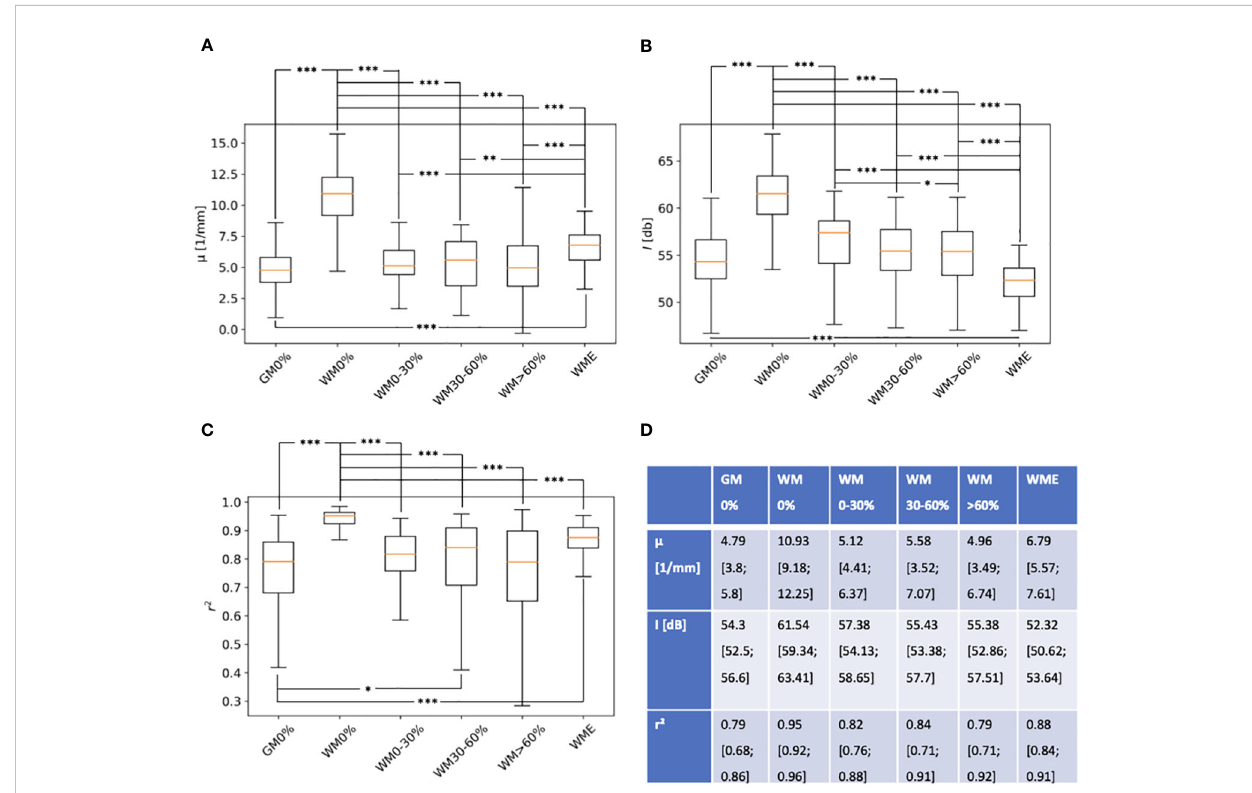
FIGURE 4 Boxplots for three extracted optical properties (A) - m , (B) – I and (C) – r 2 in regard to different tissue types (GM0%, gray matter with 0 tumor in fi ltration; WM0%, white matter with 0% tumor in fi ltration; WMO-30%, white matter with 0-30% tumor in fi ltration; WM30-60%, white matter with 30-60% tumor in fi ltration; WM>60%, white matter with > 60% tumor in fi ltration and WME, white matter with edema). Highly signi fi cant differences (p-value <0,001) were marked with ***, signi fi cant differences (p-value < 0,01) were marked with **, signi fi cant differences (p-value < 0,05) were marked with *. Numerical values of the optical properties are displayed in (D) , representing median, 25 and 75